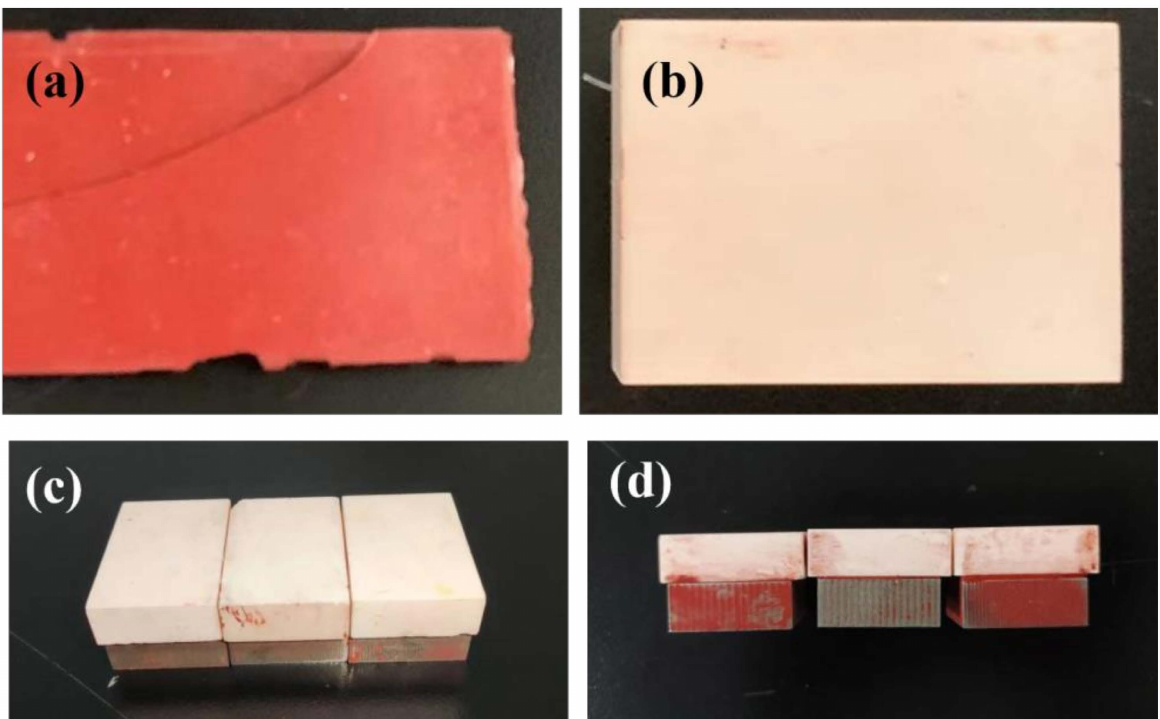
Figure 3. Physical map of samples: ( a ) glue; ( b ) ceramics; ( c ) real picture of sample with different adhesive thickness; ( d ) side view of the sample.